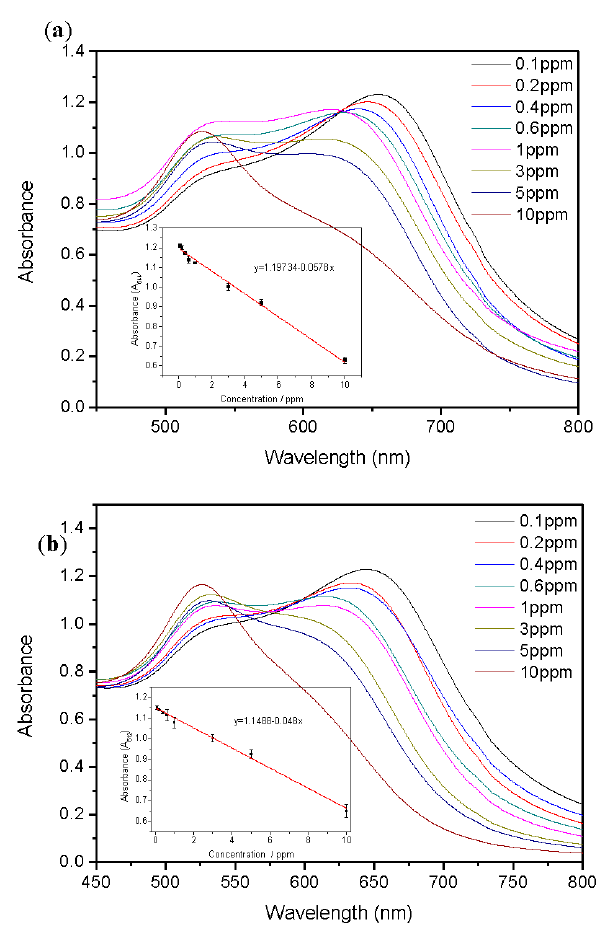
Figure 8. UV ‒ vis absorption spectra of functionalized AuNPs under di ff erent concentrations of ( a ) Figure 8. UV-vis absorption spectra of functionalized AuNPs under different concentrations of Ace and ( b ) Nap. ( a ) Ace and ( b ) Table 1. Comparison of LOD for analytes with literature values.